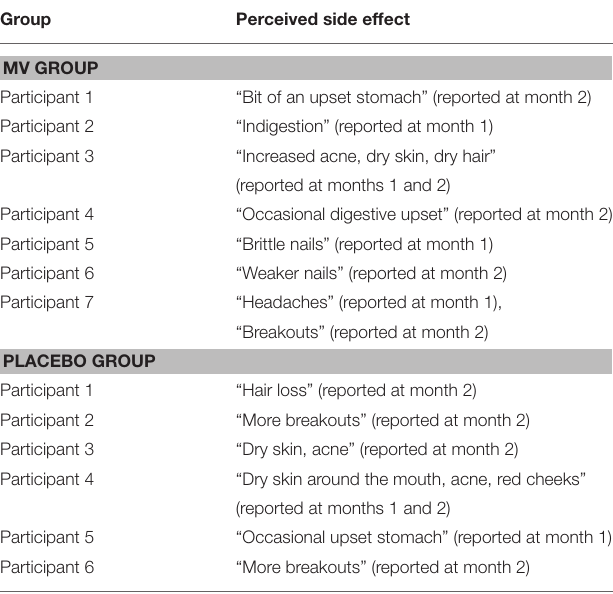
TABLE 1 | Perceived side effects.